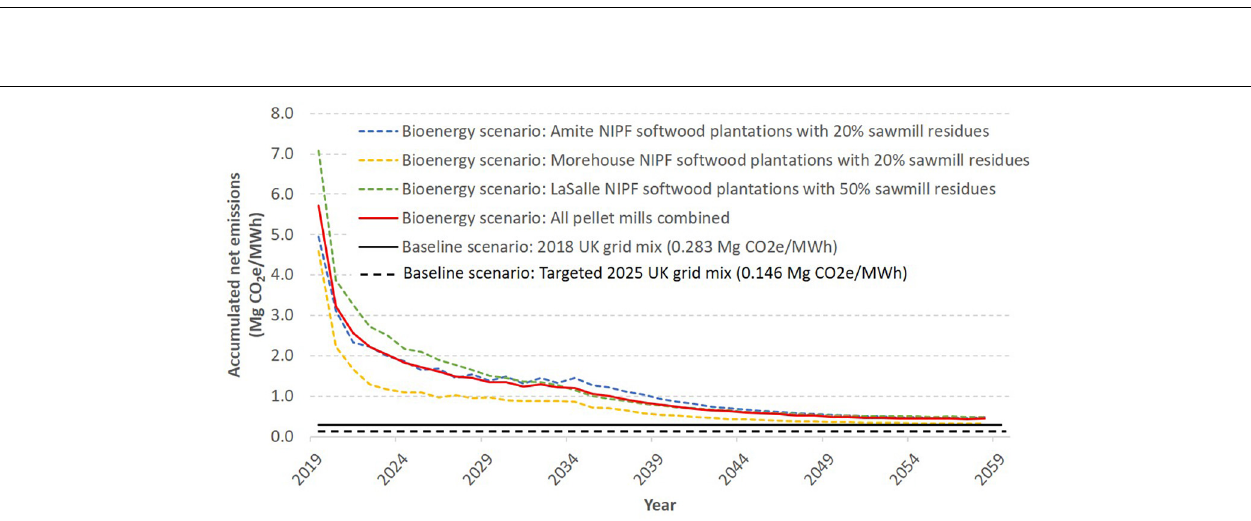
Frontiers in Forests and Global Change |